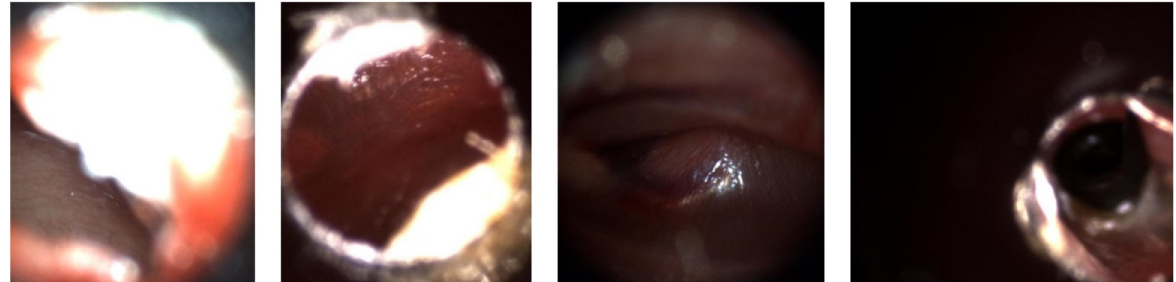
Fig 6. Some difficult to determine diagnosis images from folds: 3, 5, and